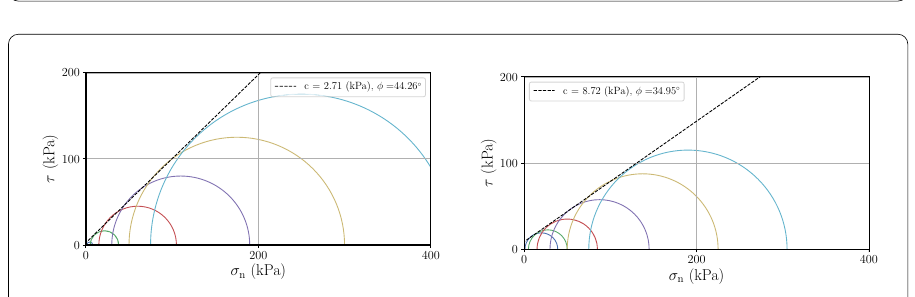
Fig. 6 The Mohr circles for determining the internal friction and cohesion from triaxial test on gravel-1 (left) and wet-sand-1 (right)